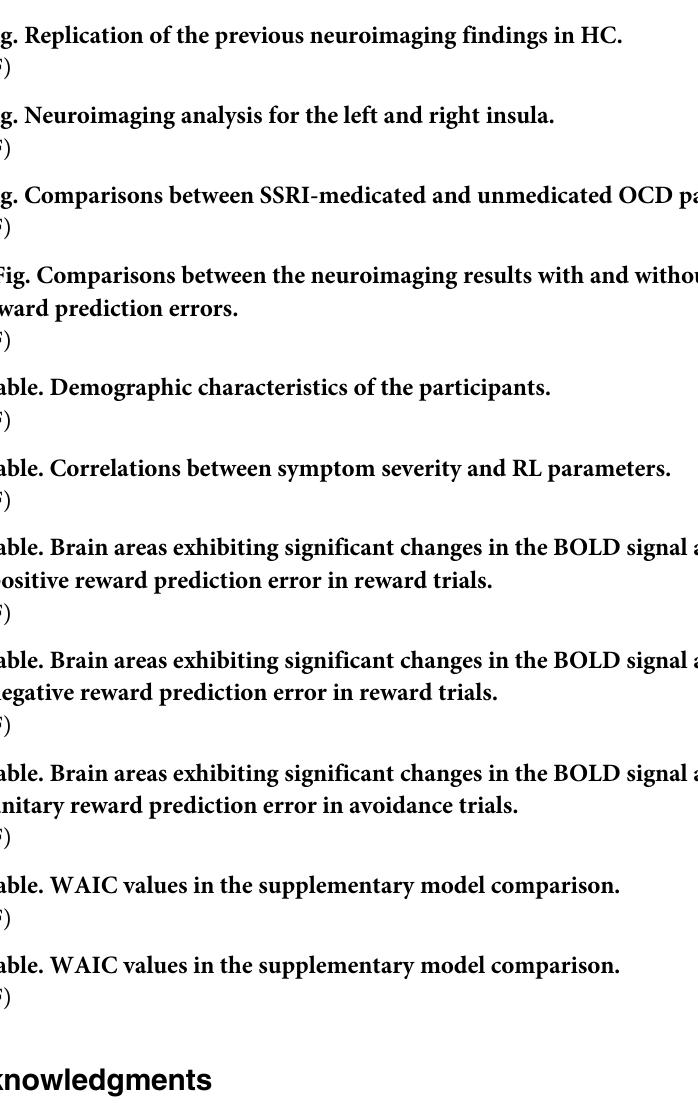
S6 Fig. Supplementary analysis of the parameter estimation. S7 Fig. Replication of the previous neuroimaging findings in HC. S8 Fig. Neuroimaging analysis for the left and right insula. S9 Fig. Comparisons between SSRI-medicated and unmedicated OCD patients. (PDF) S10 Fig. Comparisons between the neuroimaging results with and without z-normalisation of reward prediction errors. S1 Table. Demographic characteristics of the participants. S2 Table. Correlations between symptom severity and RL parameters. S3 Table. Brain areas exhibiting significant changes in the BOLD signal associated with the positive reward prediction error in reward trials. S4 Table. Brain areas exhibiting significant changes in the BOLD signal associated with the negative reward prediction error in reward trials. S5 Table. Brain areas exhibiting significant changes in the BOLD signal associated with the unitary reward prediction error in avoidance trials. S6 Table. WAIC values in the supplementary model comparison. S7 Table. WAIC values in the supplementary model